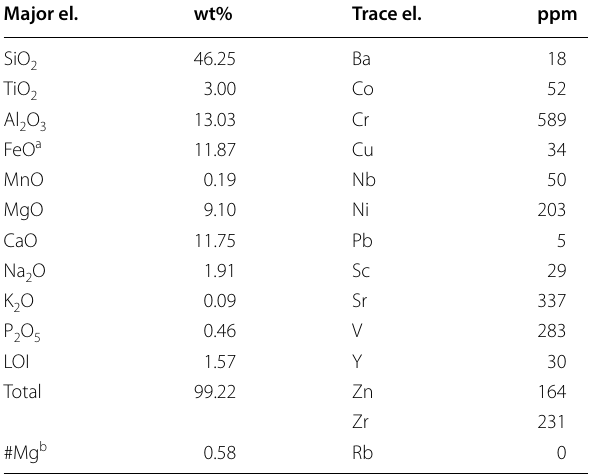
a Total iron as FeO b